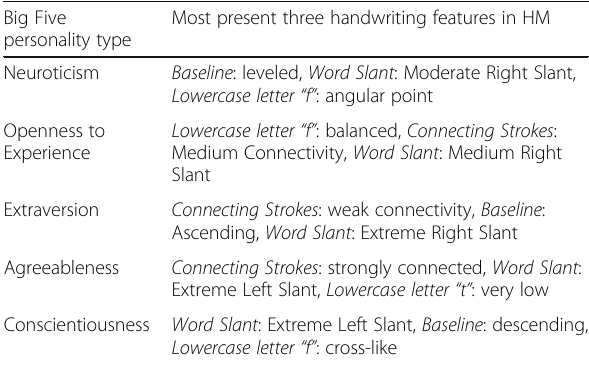
Table 4 Correlation between the handwriting features and the Big Five personality types Big Five Most present three handwriting features in HM personality type Neuroticism Openness to Experience